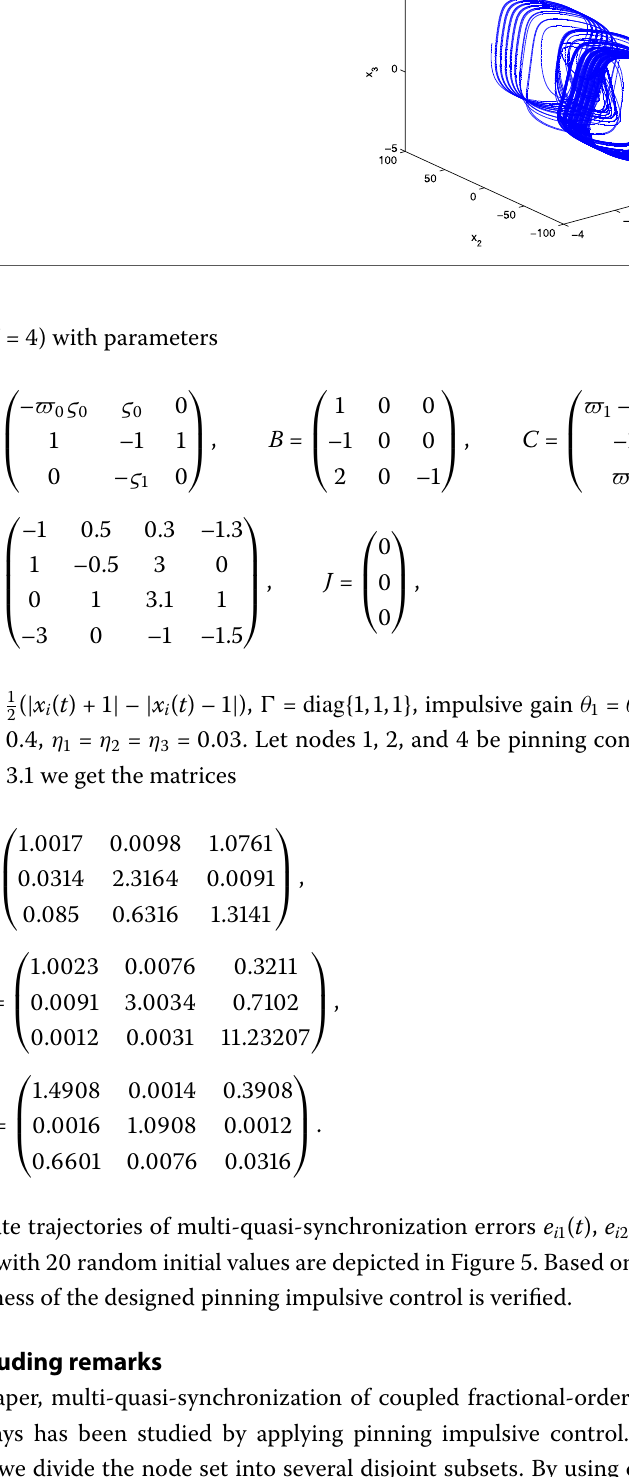
Figure 4 Chaotic behaviors of Chua’s